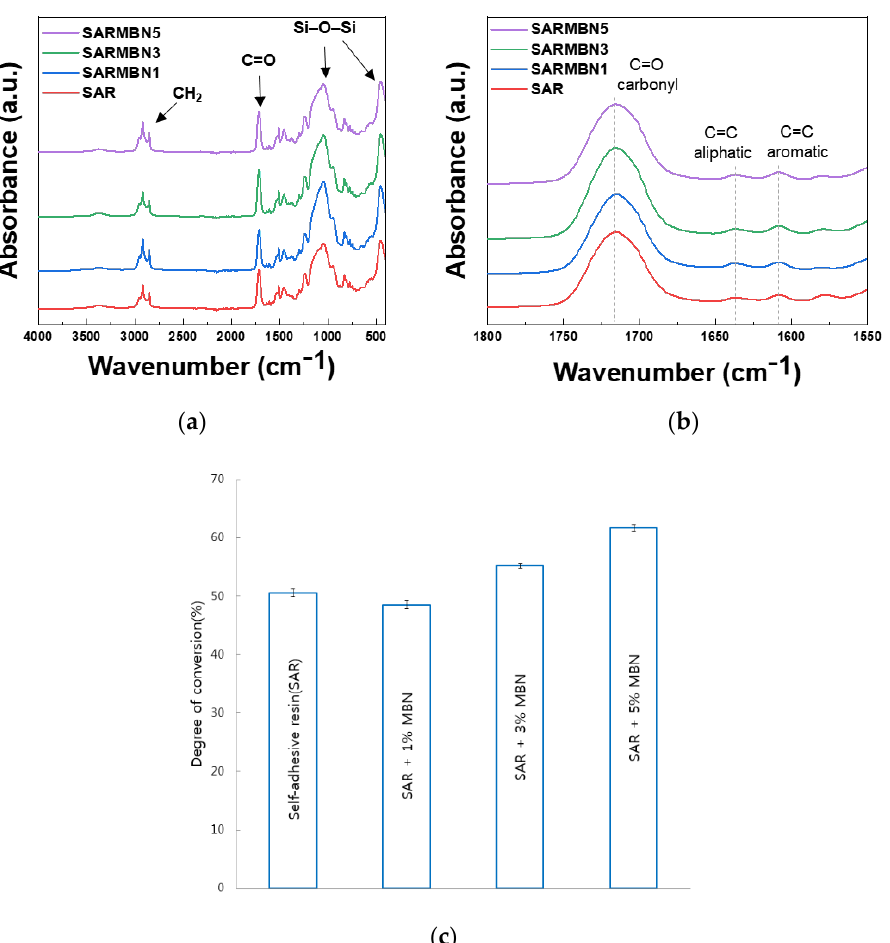
Figure 8. FTIR spectra of SAR and SAR + 1, 3, and 5% MBN; ( a ) 4000–400 cm − 1 ; ( b ) 1800–1550 cm − 1 and ( c ) degree of conversion value of the control (SAR) and MBN-incorporated SAR groups ( n = 5).